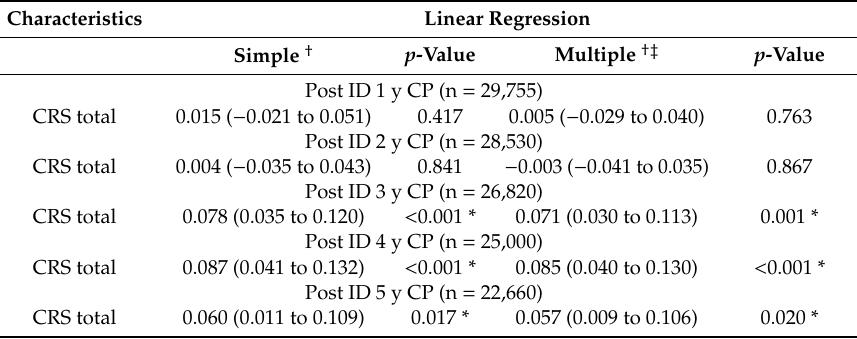
Table 2. Simple and multiple linear regression model (estimated value (95% confidence interval)) for post index date of CP (post-ID CP) periods in CRS with / without nasal polyp (total) group compared to control group.